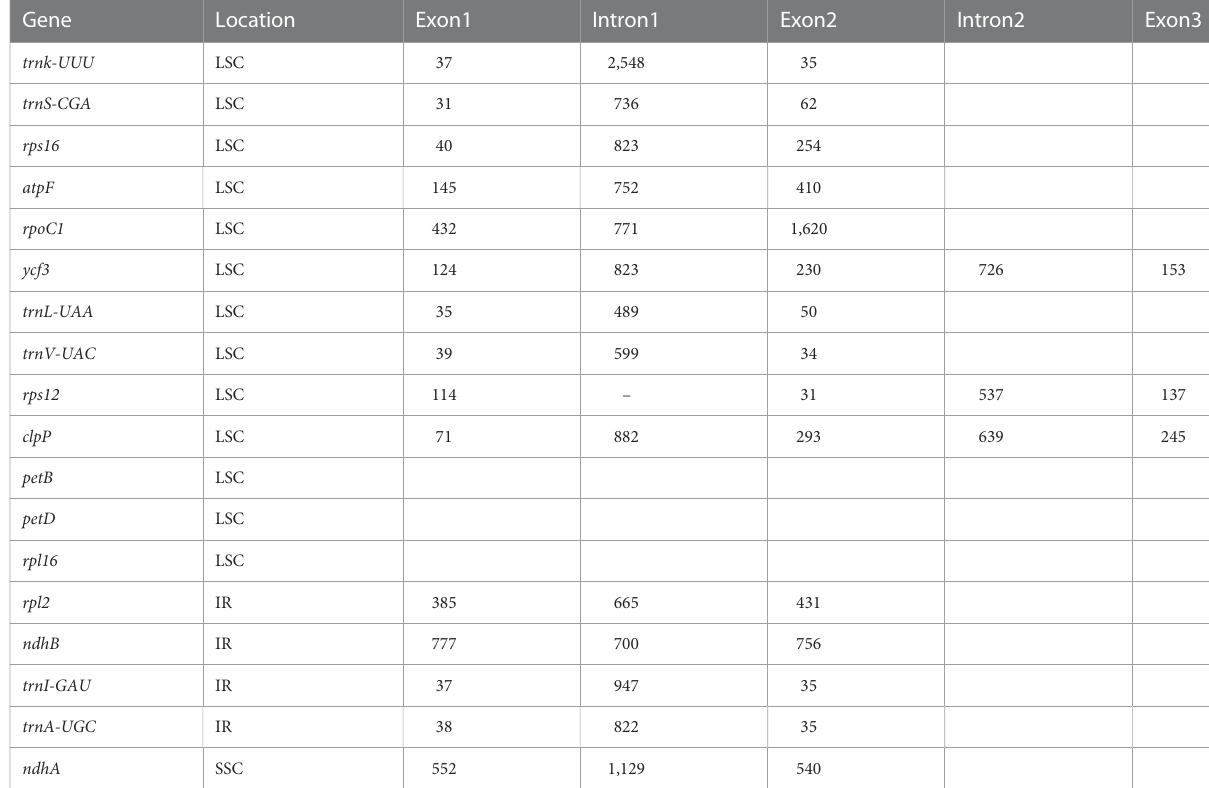
TABLE 3 Length of exons and introns in chloroplast genes of Piper